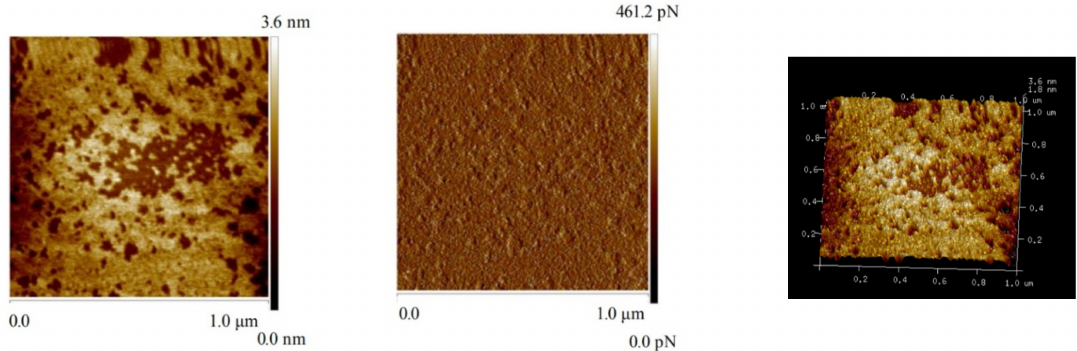
Figure 12. Height and Peak Force Error image of bare talc (c(CLS) = 0 mg/L, pH = 8).